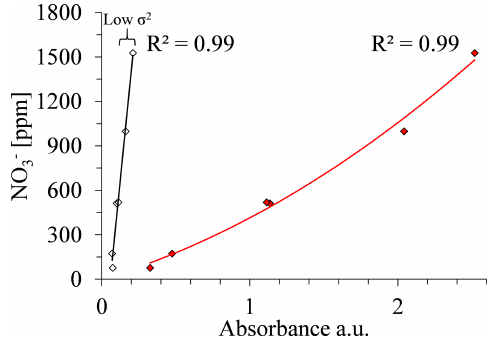
Figure 6. Relationship between coefficient of determination ( R 2 ), variance ( σ 2 ), and the UV spectrum for the open crop field. p (R 2 + σ 2 ) was calculated only for values where R 2 exceeded the set threshold at R 2 . The maximum calculated value was deter- 98% mined as the optimal wavelength and was set to 238nm.